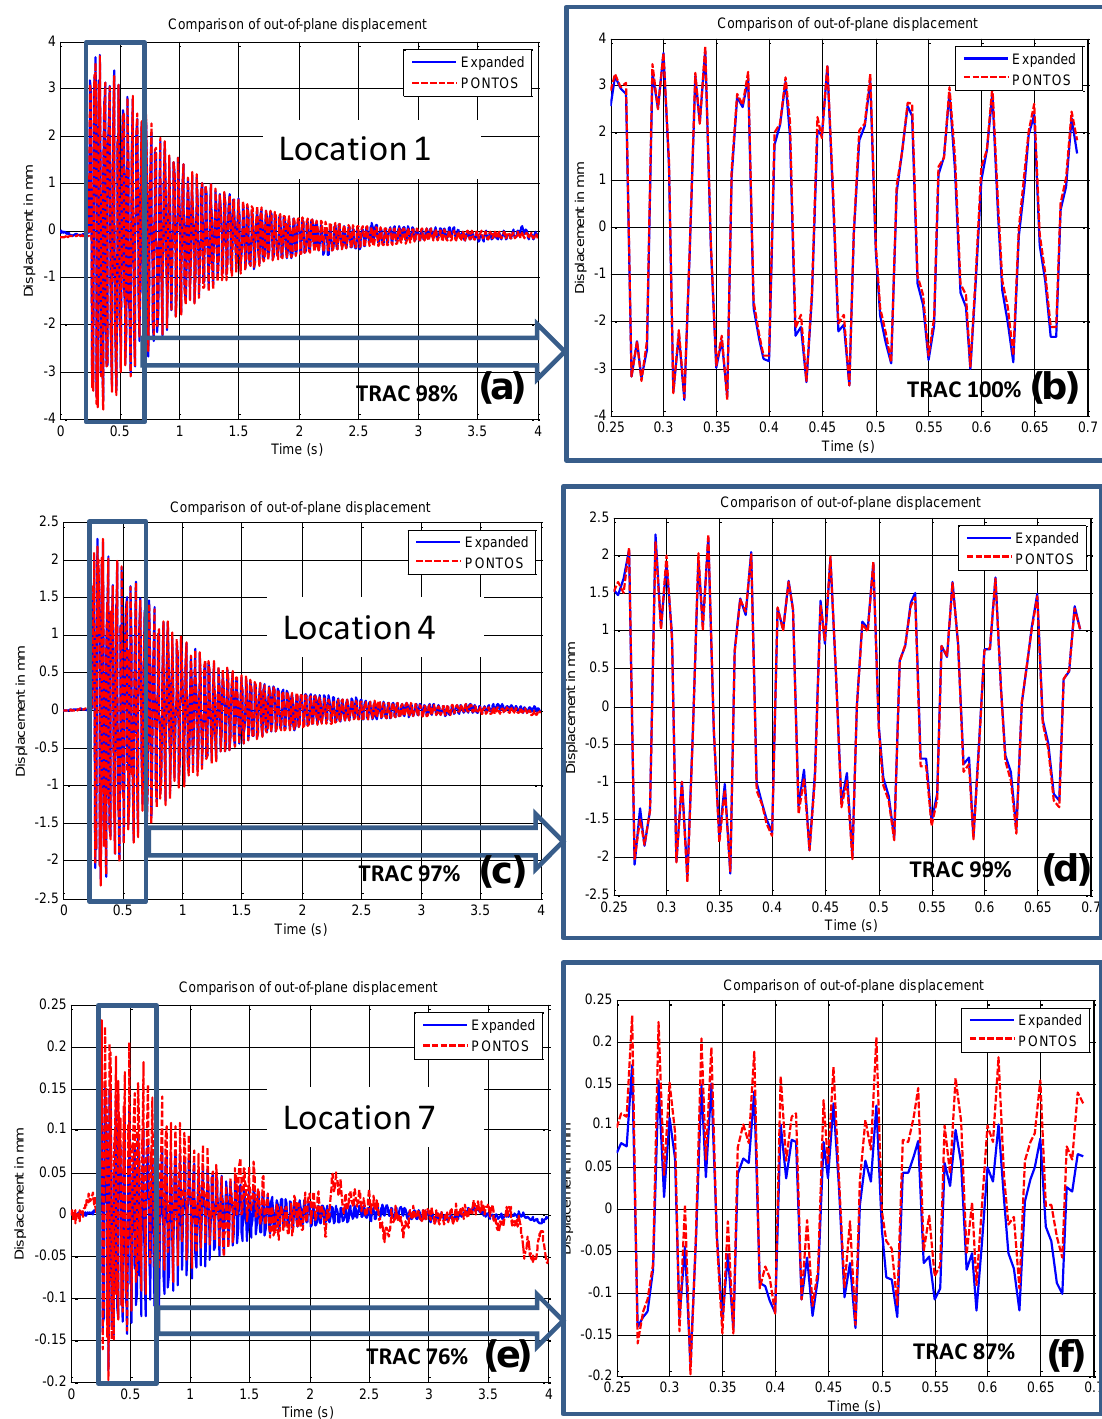
Fig. 11. Overlay of the displacement responses (shown for complete and initial transient period) from predicted solution using first five modes for expansion and PONTOS at three different locations of the